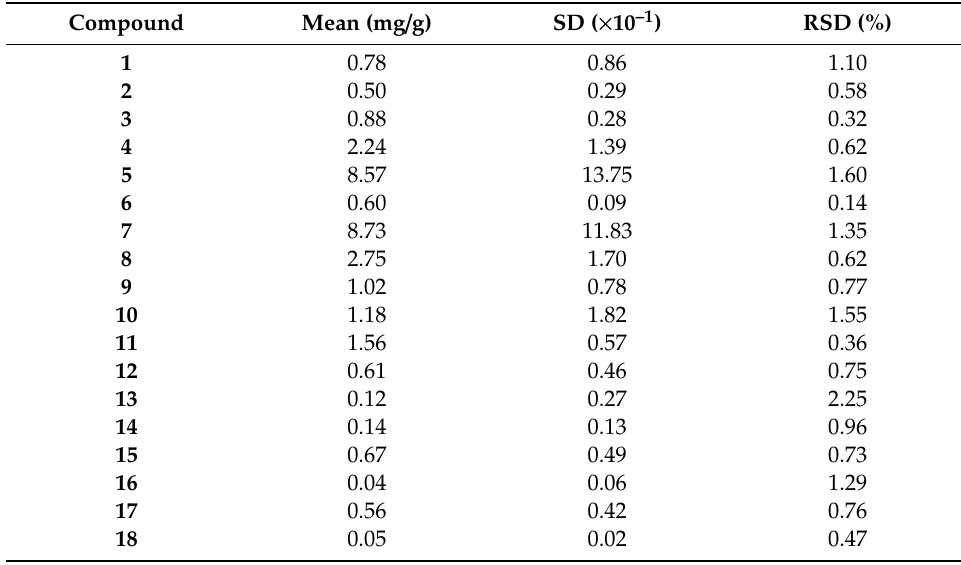
Table 4. Concentration of compounds 1 – 18 in Gami-soyosan ( n =